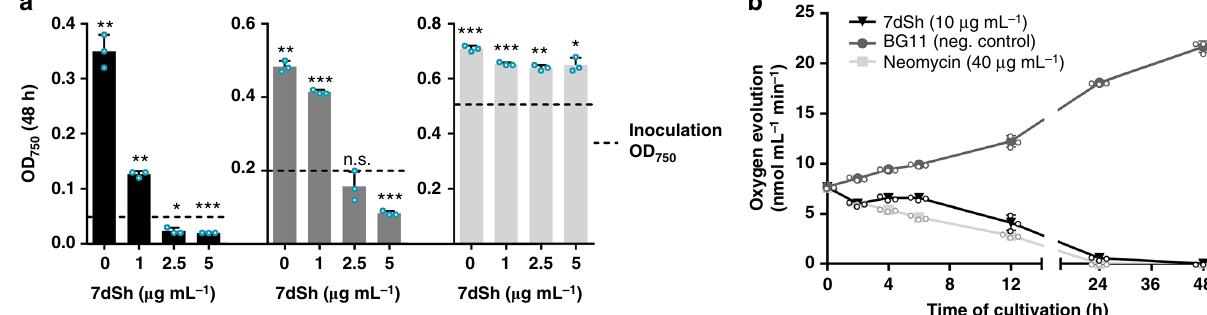
Fig. 3 Effect of 7dSh ( 1 ) on the growth and photosynthetic oxygen evolution of A. variabilis cultures. a Growth of A. variabilis (OD 750 ) at different concentrations of 7dSh after 48 h of incubation. Cultures were inoculated to an OD 750 of 0.05, 0.2, or 0.5 (marked by dashed lines). 7dSh in aqueous solution was added at time 0. Signi fi cant differences between adjusted initial OD 750 and OD 750 after 48 h were analyzed in a one sample t -test (* p -value < 0.05; ** p -value < 0.01; *** p -value < 0.001; n.s., not signi fi cant). b Photosynthetic oxygen evolution by A. variabilis (initial OD 750 = 0.3) in the presence of 7dSh or neomycin (positive control) or without supplementation (BG11, negative control). 7dSh (ca. 50 µ M) and neomycin (ca. 65 µ M) were added as aqueous solution. Values in both graphs represent the mean values of three biological replicates; standard deviations are indicated. Dots indicate data distribution. Source data are provided as a Source Data fi